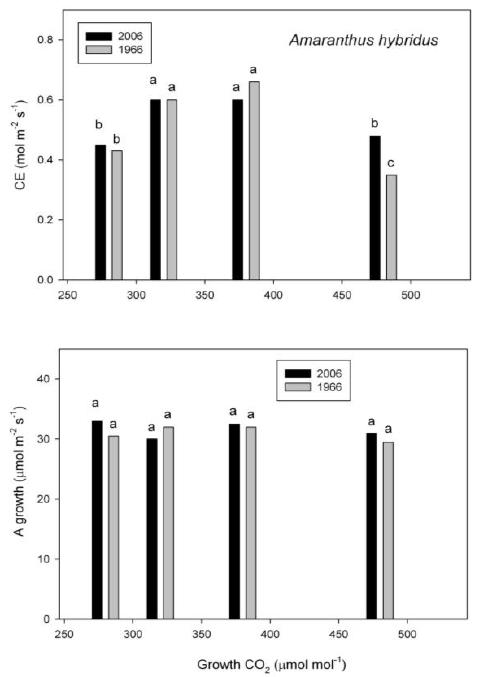
Figure 1. Carboxylation efficiency (CE) and assimilation rate (A) under the growth conditions in Amaranthus hybridus grown at four CO 2 concentrations from seeds collected in 1966 and 2006. Different letters indicate significant differences, based on analysis of variance.